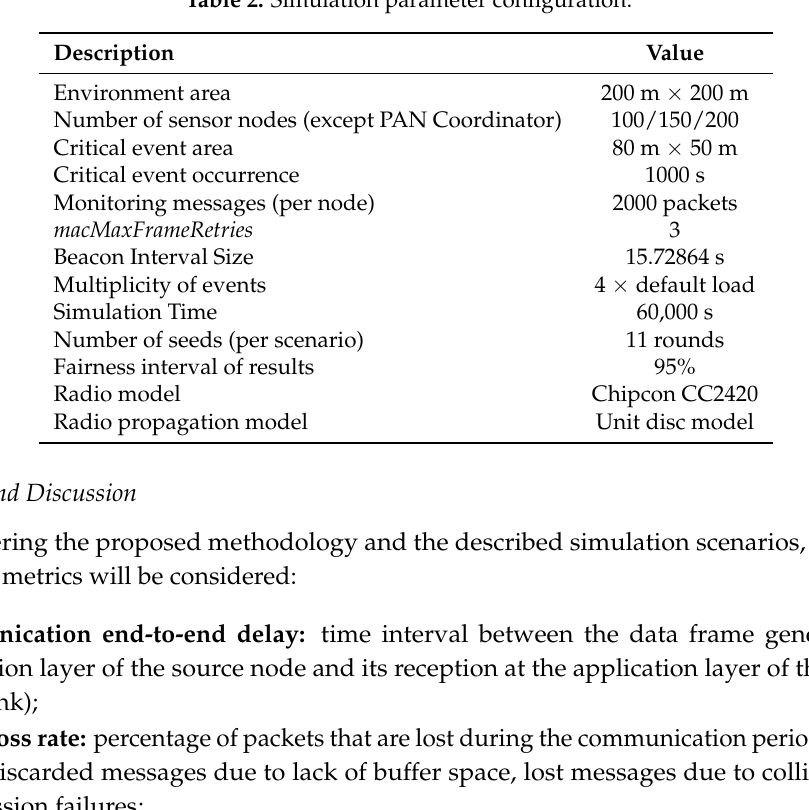
Table 2. Simulation parameter